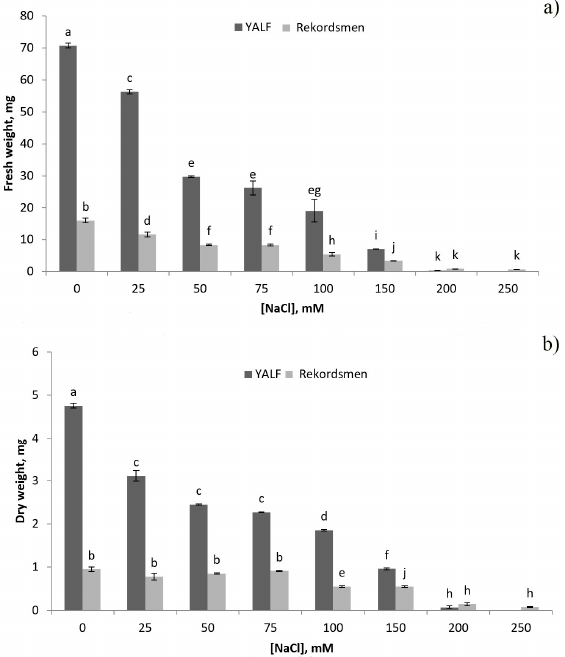
Figure 2. Effect of different concentrations of NaCl in the nutrient medium for rhizogenesis induction on the fresh ( a ) and dry ( b ) weight of roots in tomato seedlings of the YaLF line and cv Recordsmen. Means followed by the same letter are not significantly different at α = 0.05 according to Duncan’s multiple range test.